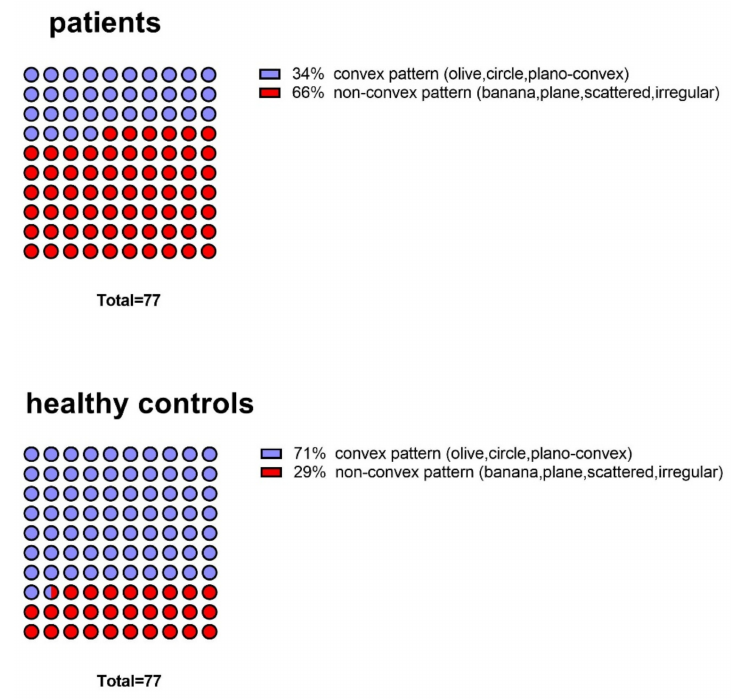
Figure 4. Pattern of OB shapes in patients and healthy controls.